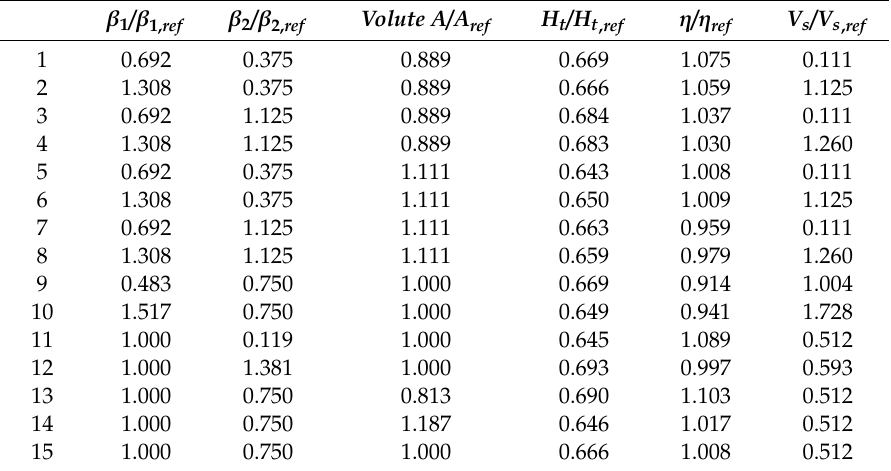
Table 2. Initial input data for the supervised machine